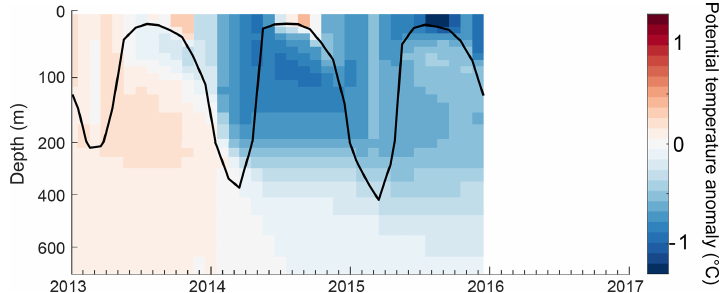
Figure B2. The potential temperature anomaly over depth relative to the 1992–2015 monthly climatology (colour; ◦ C), averaged over the cold blob region in ECCOv4-r3. The MLD is also shown (black line, m). Note the non-uniform spacing of the vertical axes.